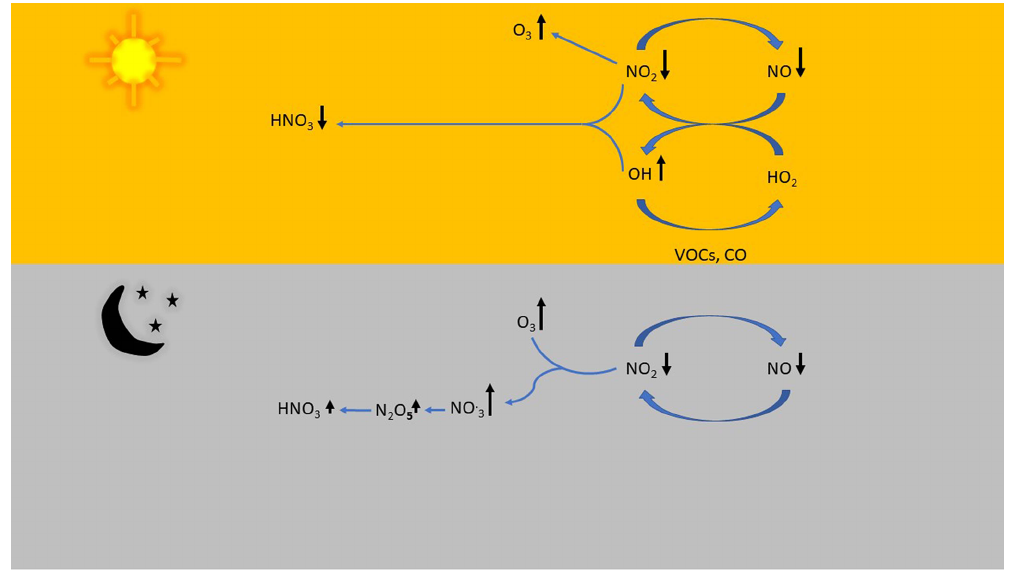
Figure 5. Generalized schematic diagram of daytime and nighttime lockdown NO x chemistry compared to the BAU